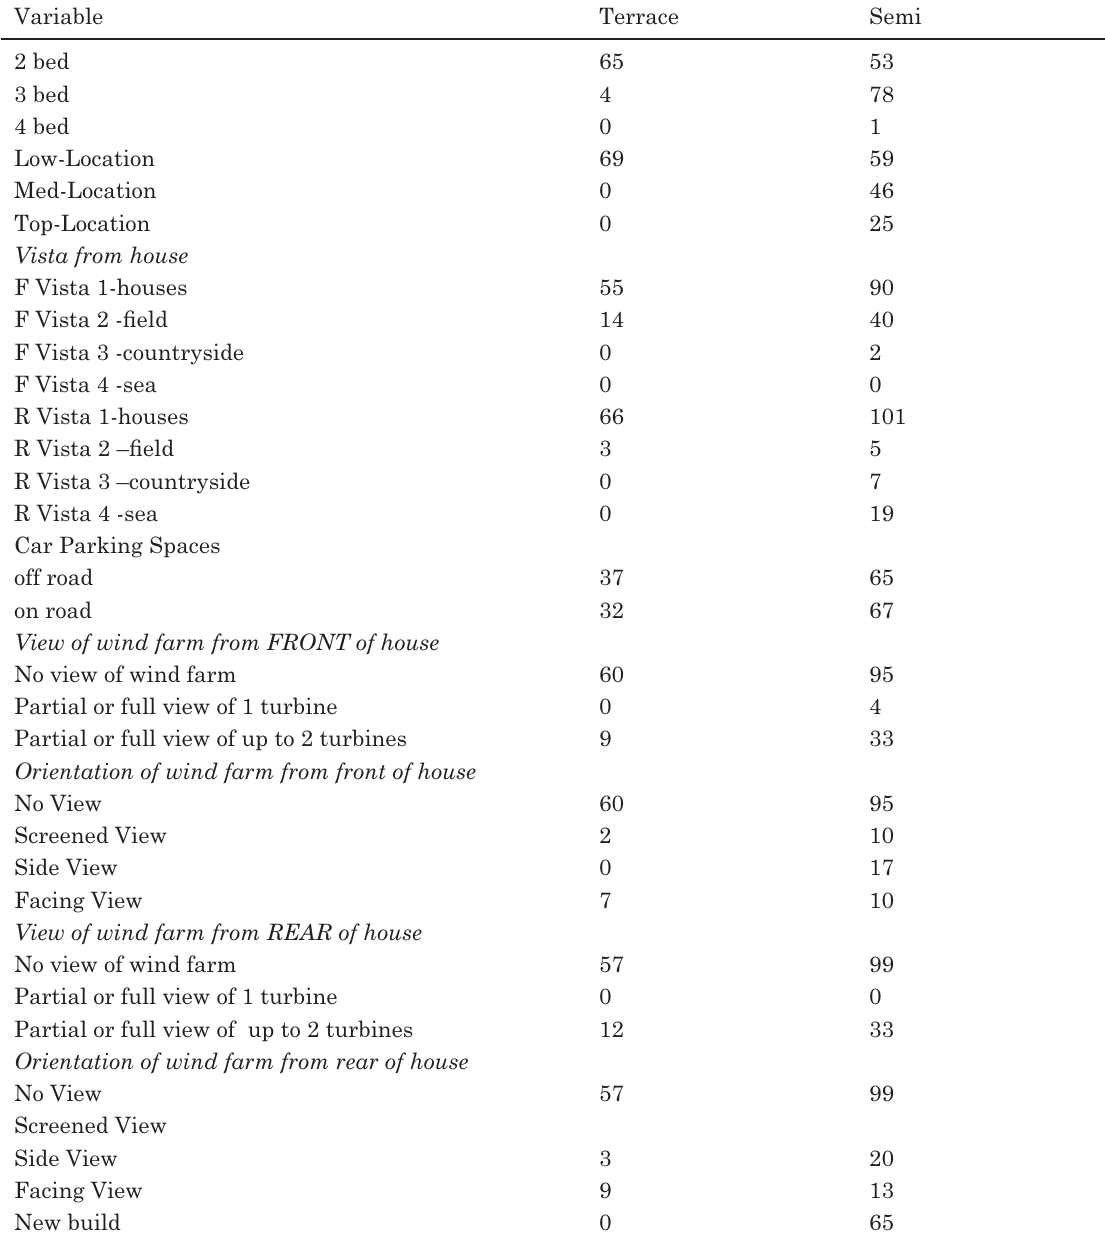
Table 3. Frequency analysis of variables – relative to house